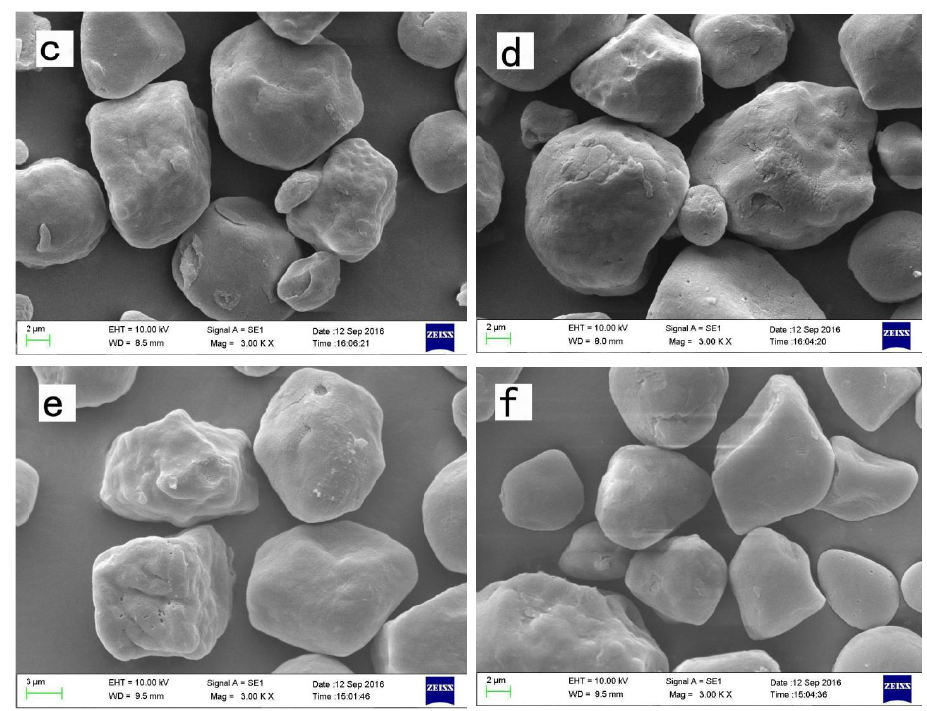
Figure 1. SEM ( a ) raw waxy corn; ( b ) CLAC-1; ( c ) CLAC-2; ( d ) CLAC-3; ( e ) CLAC-4; ( f ) CLAC-5.